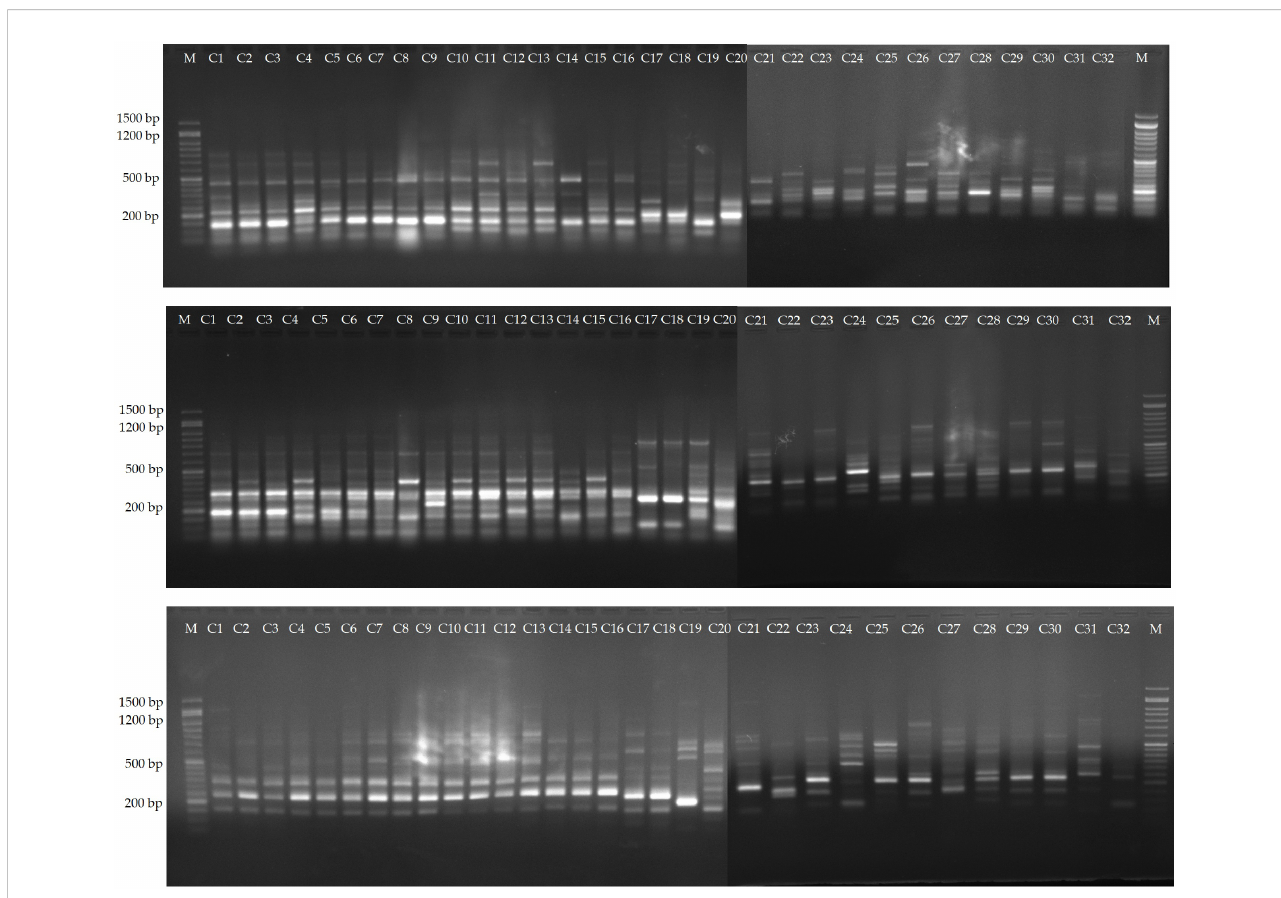
FIGURE 4 Ampli fi cation pro fi les of markers me1-em4, me1-em6 and me2-em3. Lane 1-16, C. persicum cultivars, 16-32, different Cyclamen